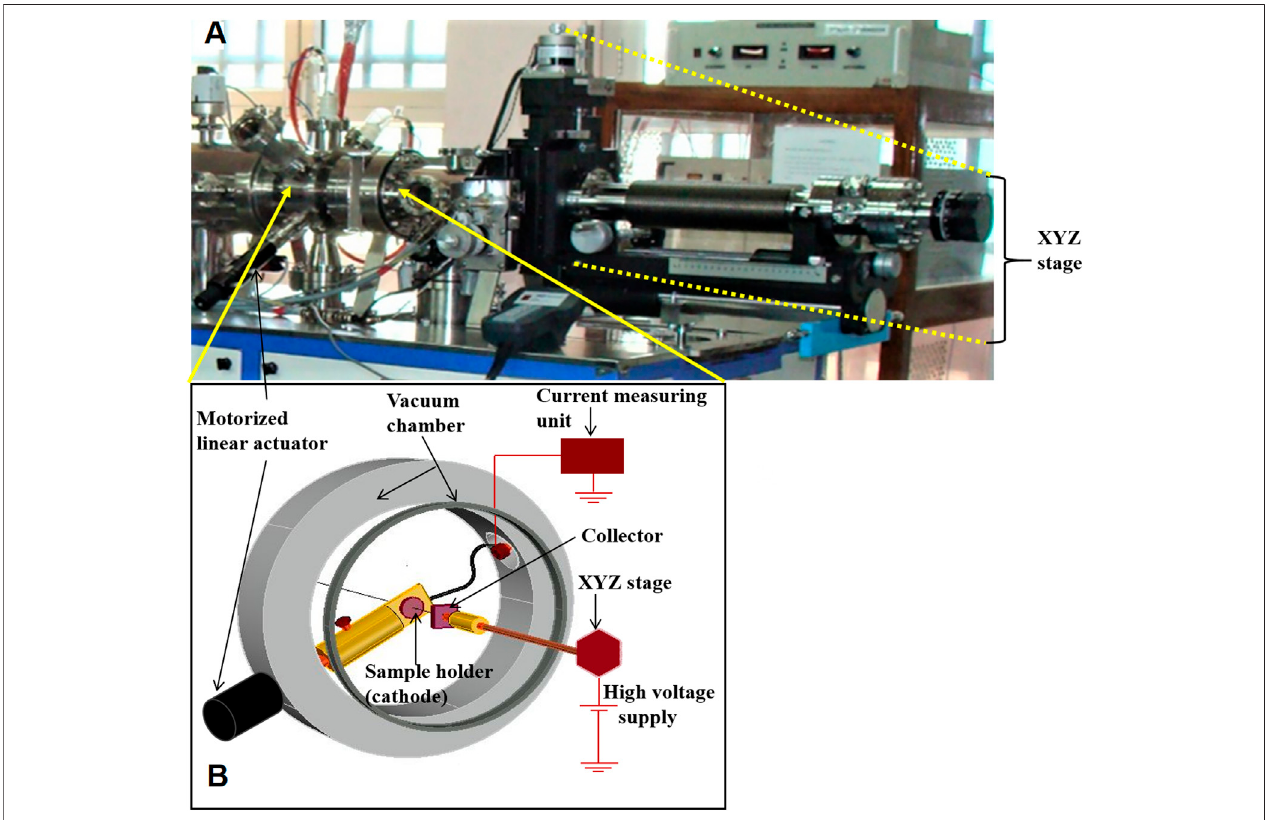
FIGURE 2 | (A) Digital picture of experimental setup for fi eld emission measurement experiment (not to scale); (B) the corresponding schematic diagram.